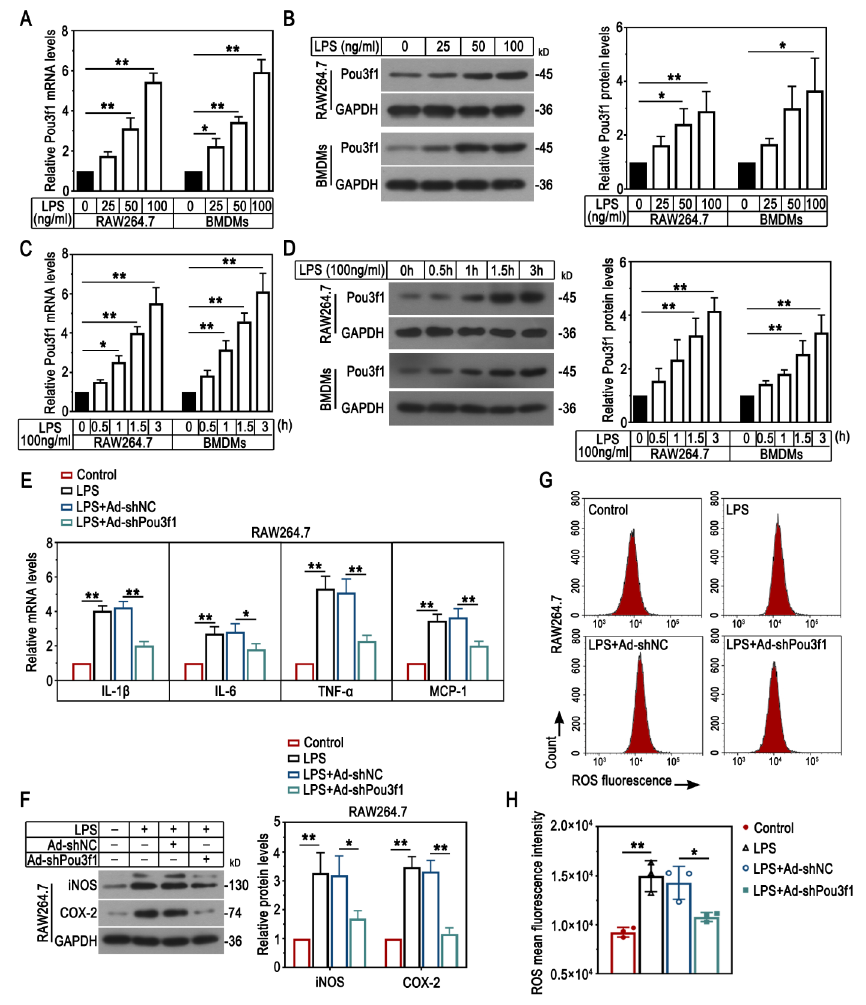
Fig. 3 Pou3f1 knockdown ameliorated LPS-induced inflammation in macrophages. (A-D) The mRNA and protein levels of Pou3f1 in RAW264.7 cells and BMDMs in response to LPS were determined by qPCR and Western blot. (E) The relative mRNA levels of IL-1β, IL-6, TNF-α and MCP-1 were determined by qPCR. (F) The protein levels of iNOS and COX-2 were detected using Western blot. (G-H) Flow cytometry analysis and quantification results for the fluorescence intensity of ROS. n = 3. Values were mean ± SD. *, p < 0.05; **, p <